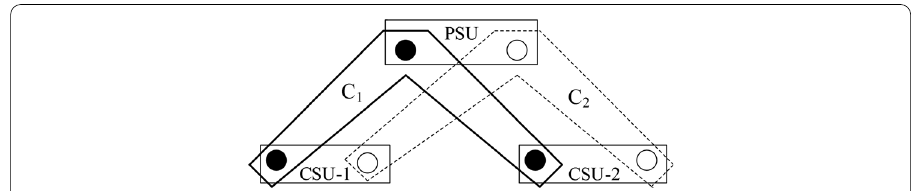
Fig. 1 The network structure of our system consisting of two subnets (clusters) C 1 and C